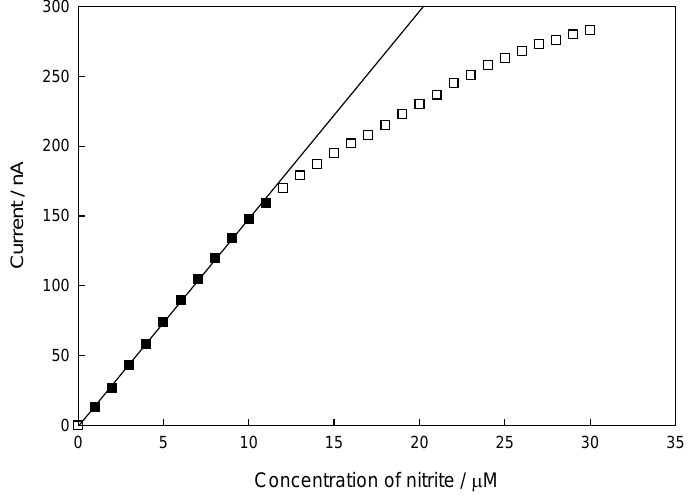
Figure 9. Calibration curve of the